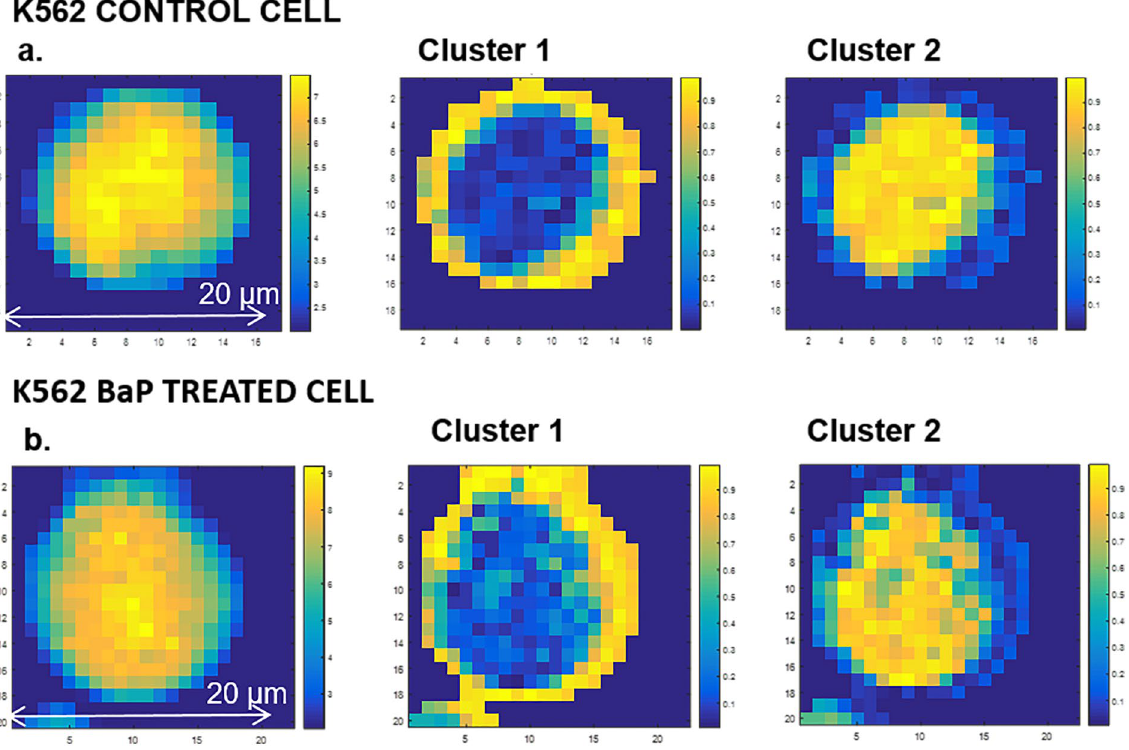
Figure 7. FCM images of a representative control and BaP treated K562 formalin fixed cell.